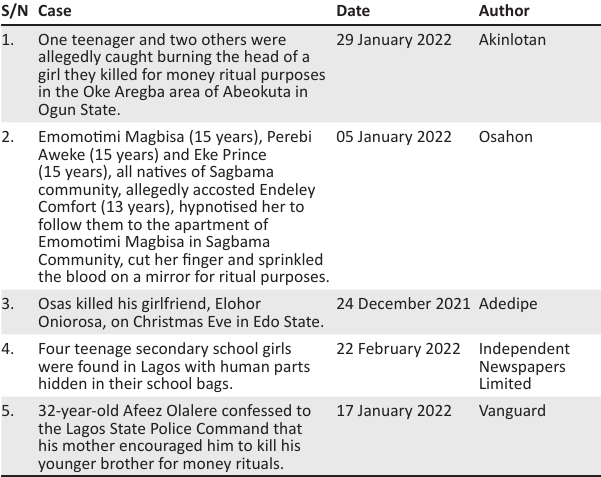
TABLE 1: Selected cases of blood money rituals in